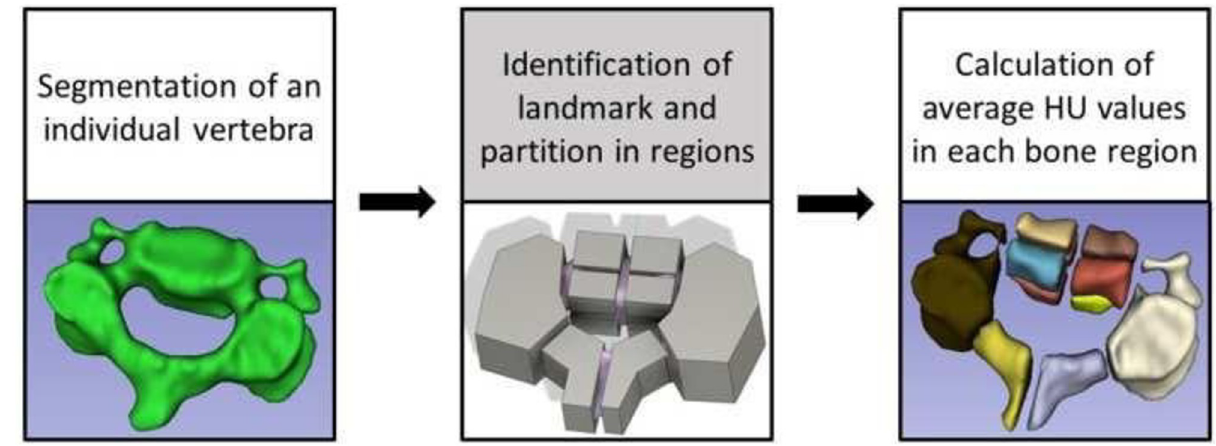
Fig 1. Workflow to segment and partition vertebrae in bone